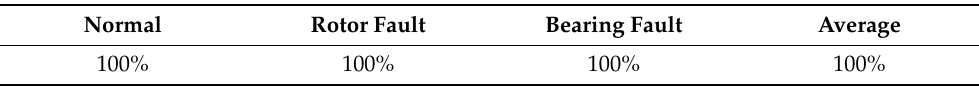
Table 7. Diagnostic accuracy of convolutional neural network through two-fold cross validation.